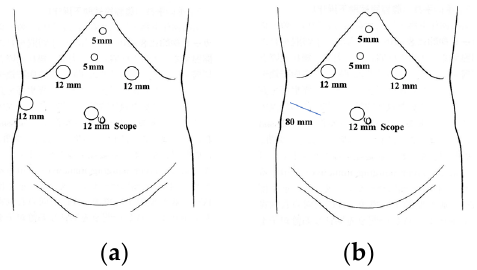
Figure 2. ( a ) Trocar placement for pure LLR. ( b ) Trocar placement for HALS. The blue line is the incision placed by a hand - assisted device.